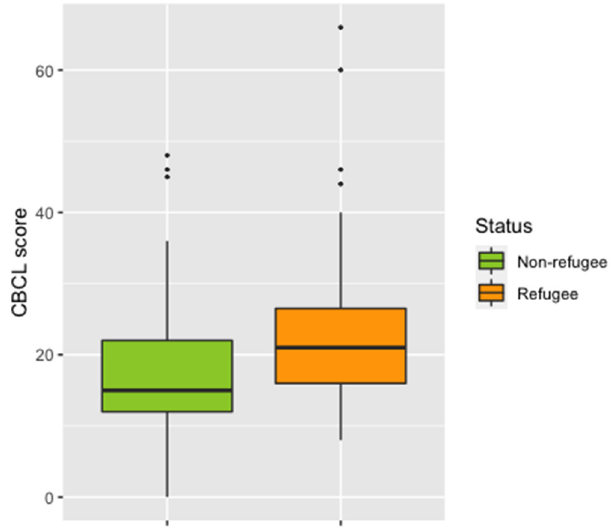
Figure 1. Distribution of refugee and non-refugee children’s scores to the Child Behavior CheckList (CBCL).